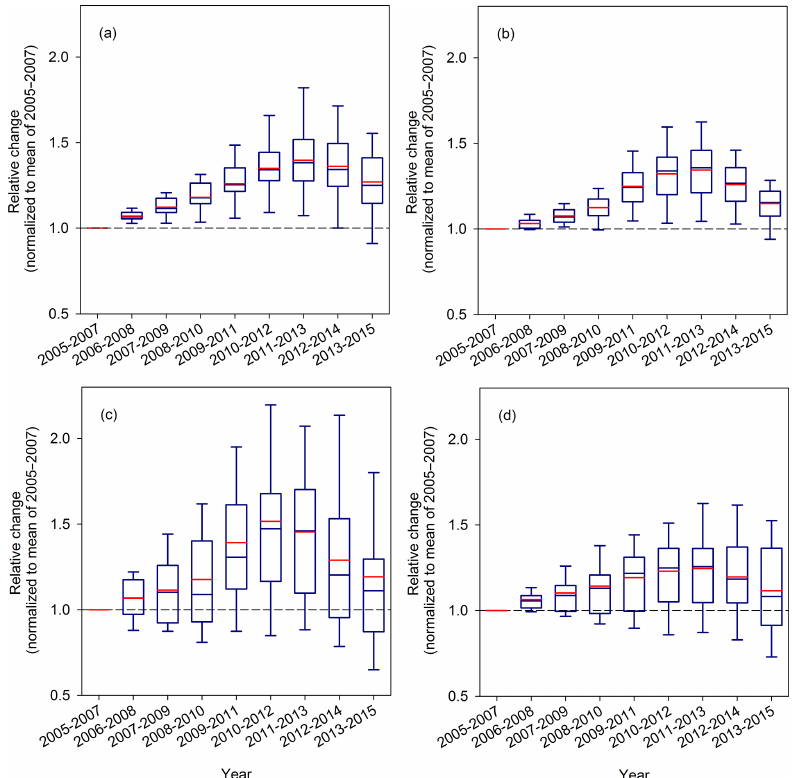
Figure 5. Comparisons of the trends in satellite observations (left panels) with those in the bottom-up emission inventory (right panels) at the province (top panels) and city (bottom panels) level during 2005 to 2015. The box plots show the relative changes in (a) the average OMI tropospheric NO 2 column densities for provinces in China; (b) the anthropogenic NO x emissions for provinces in China; (c) the fitted NO x emissions for cities investigated in this study; and (d) the anthropogenic NO x emissions for the corresponding cities. The blue horizontal line is the median of the relative differences; the red horizontal line is the mean of the relative differences; the box denotes the 25 and 75% percentiles; and the whiskers denote the 10 and 90% percentiles. The bottom-up emission data are derived from the MEIC